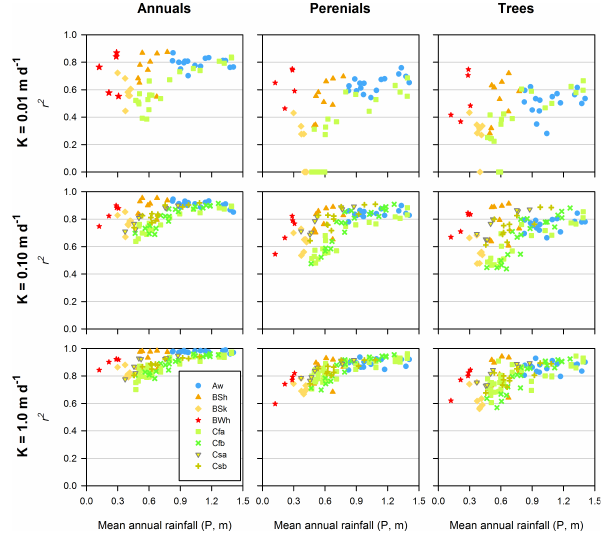
Fig. 6. Scatter plots of mean annual rainfall ( P ) and the coeffi- cient of correlation ( r 2 ) between mean annual recharge ( R ) and mean annual P for all modelled locations within considered cli- mate types, under soil with selected hydraulic conductivities and vegetation